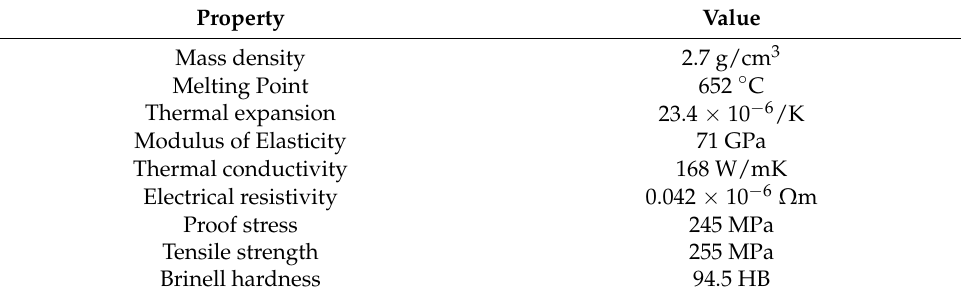
Table 2. Properties of